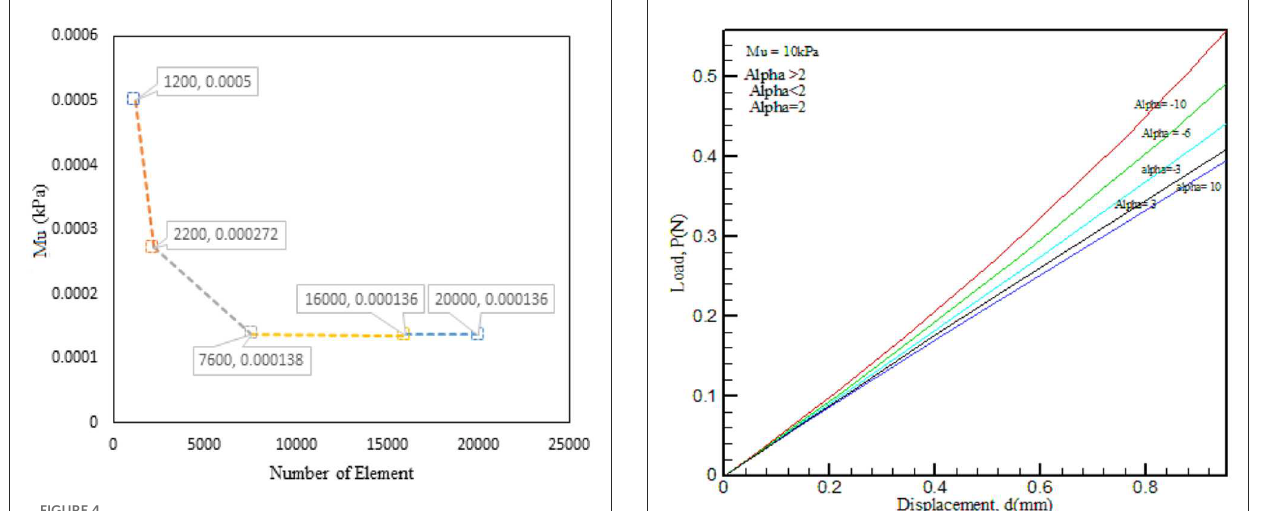
FIGURE4 Graph of µ vs. number of elements for PVA-C modeled with 5% concentration and finite thickness.